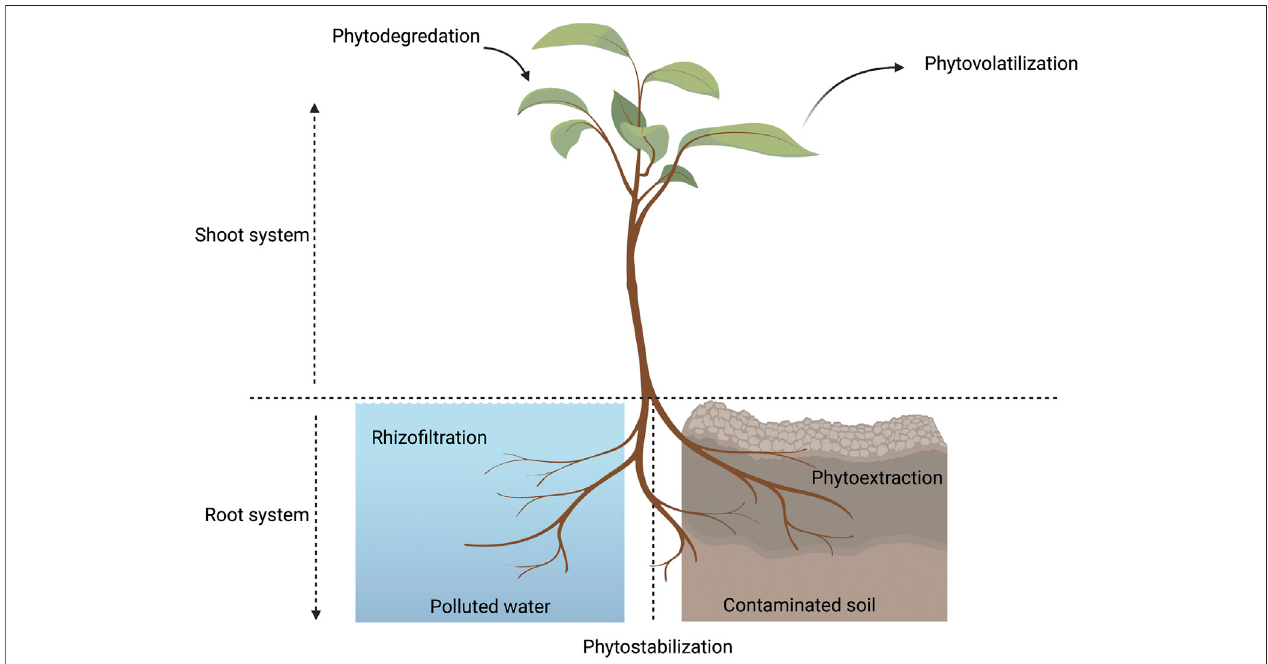
FIGURE 2 | A diagram showing the different phytoremediation techniques used by plants in different environments. Phytoremediation techniques are divided into fi ve main areas. 1) Phyto-stabilization is immobilization of contaminants and pollutants in the soil, consequently reducing their bioavailability and decreasing the risk of leachinginto water or spreading in air (Morikawa and Erkin 2003). 2) Phytoextraction iscarried out by pollutant accumulation in plants (Lee 2013), 3) Phytodegradationis is the conversion of toxic pollutants into less harmful and non-toxic materials (Cunningham et al., 1995; Newman et al., 1997; Lee 2013), 4) Rhizo- fi ltration (Phyto- fi ltration) involves either plant roots (rhizo fi ltration) or plant shoots (caulo fi ltration) or seedlings (blasto fi ltration) eliminating pollutants from water or wastewater (Mesjasz- Przyby ł owicz et al., 2004; Yan et al., 2020), 5) Phytovolatilization is the conversion of toxic volatile elements into less toxic forms after being taken up from the soil and consequently released into the air through transpiration process via leaves (Mahar et al., 2016) This fi gure is created by BioRender